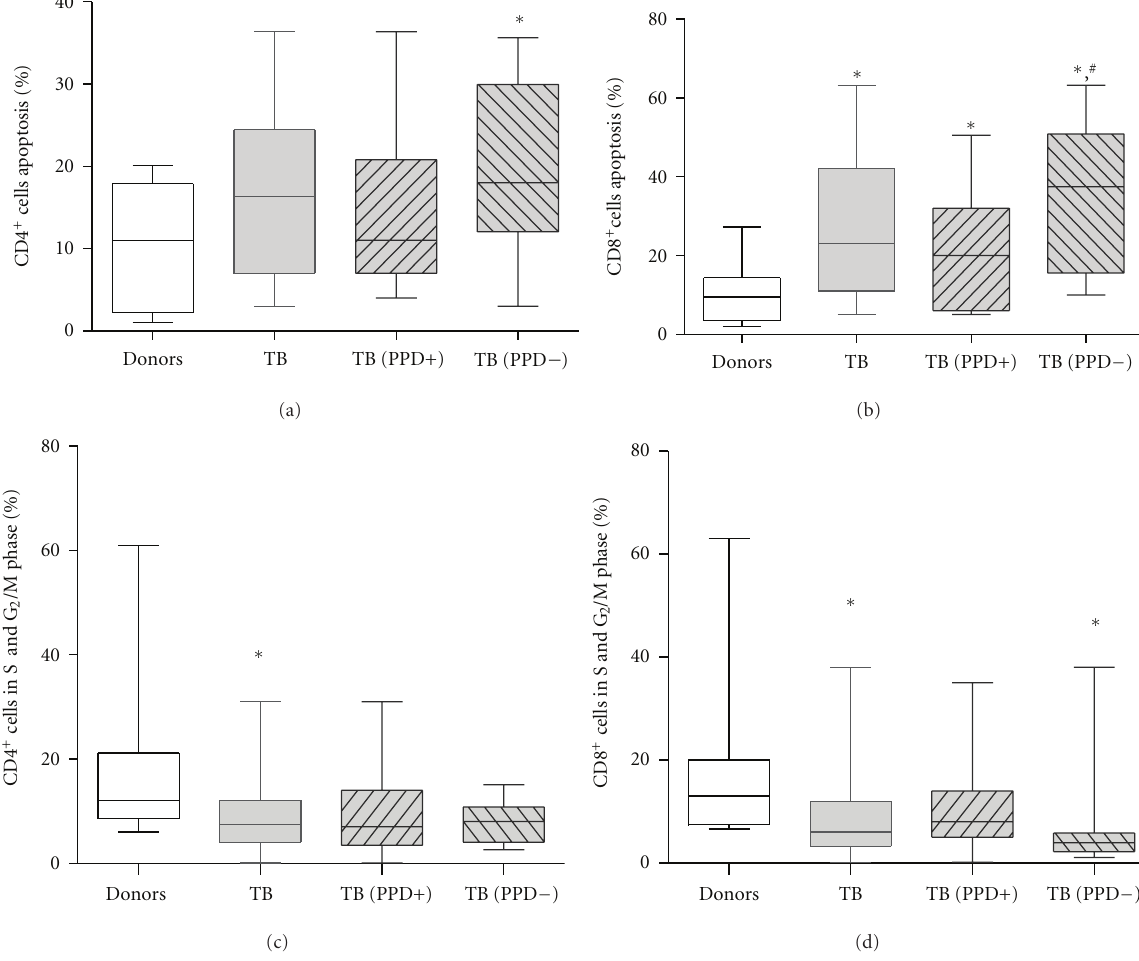
Figure 2: The apoptosis of T cells in allo-MLC stimulated with TB patient DCs was higher, and T cell proliferation was lower than that stimulated with healthy donor DCs. Date are presented in median value and whiskers (min to max). (a) After 3-day MLC stimulated with DCs of (PPD-) TB patients, the number of apoptotic CD4 + cells was significantly higher compared with MLC induced by healthy donor DCs. (b) After 3-day MLC stimulated with TB patient DCs the number of apoptotic CD8 + cells was significantly higher than that in MLC stimulated with healthy donor DCs. The number of apoptotic CD8 + cells in MLC stimulated with DCs of PPD-anergic TB patients was significantly higher than that in MLC cultures with healthy donor DCs ( ∗ P < 0 . 05) or PPD-responsive patient DCs ( # P < 0 . 05). (c) The number of CD4 + cells in S and G 2 /M phase of cell cycle in allo-MLC stimulated with TB patient DCs was higher than that stimulated with healthy donor DCs. (d) The number of CD8 + cells in S and G 2 /M phase of cell cycle in allo-MLC stimulated with patient DCs and DCs of PPD-anergic patients was higher than that stimulated with healthy donor DCs.